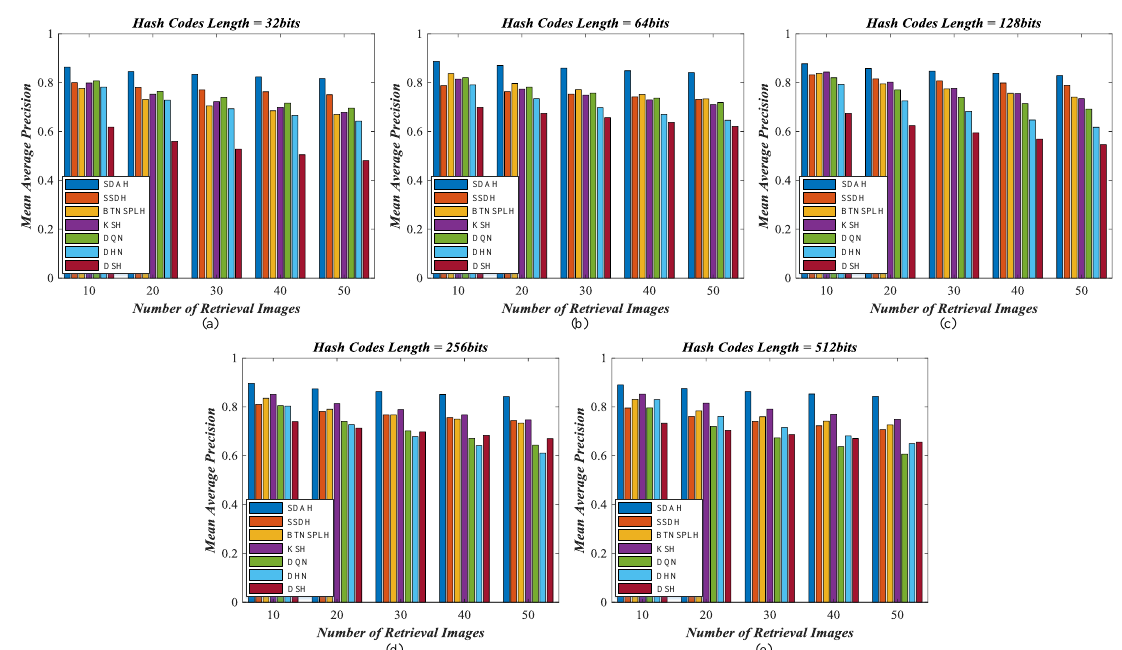
Figure 9. Mean average precision counted on different number of retrieval images using diverse hashing methods for UCM archive: ( a ) the length of hash codes is 32 bits; ( b ) the length of hash codes is 64 bits; ( c ) the length of hash codes is 128 bits; ( d ) the length of hash codes is 256 bits; and ( e ) the length of hash codes is 512